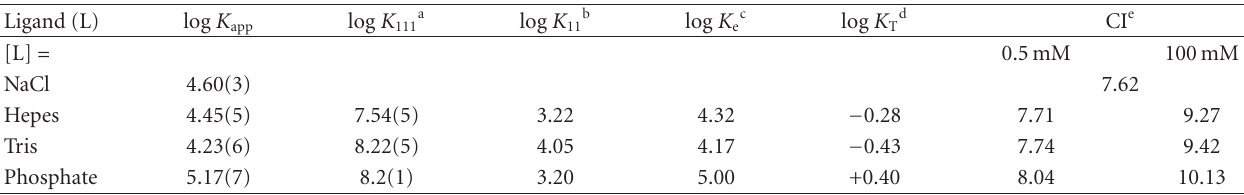
Table 1: Quantitative description of ternary complexes formed by Cu(II) ions at MBS of HSA at pH 7.4. Standard deviations of significant values of experimental logarithms constants on the last digits are given in parentheses.